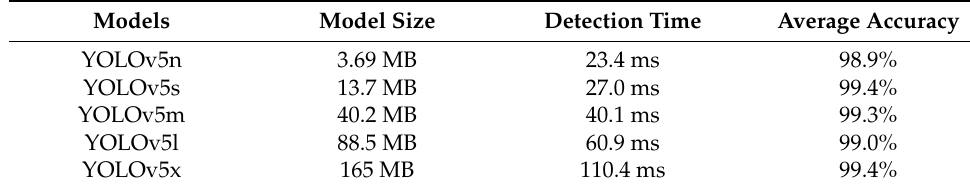
Figure 15. Training results ( a ) map curve; ( b ) validation set loss curve. The parameters of the model obtained from the training are shown in Table 2. Table 2. Comparison of detection effects of different models. Models